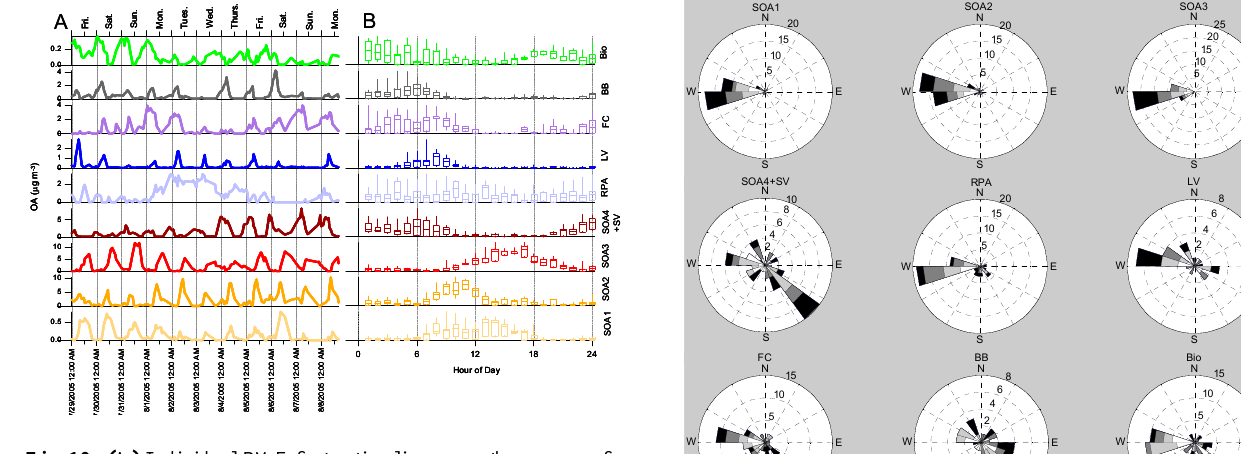
Fig. 10. (A) Individual PMF factor timelines over the summer fo- cus period (29 July–8 August). (B) Diurnal averages for summer factors. Time is in PST (=local time-1hr during summer).